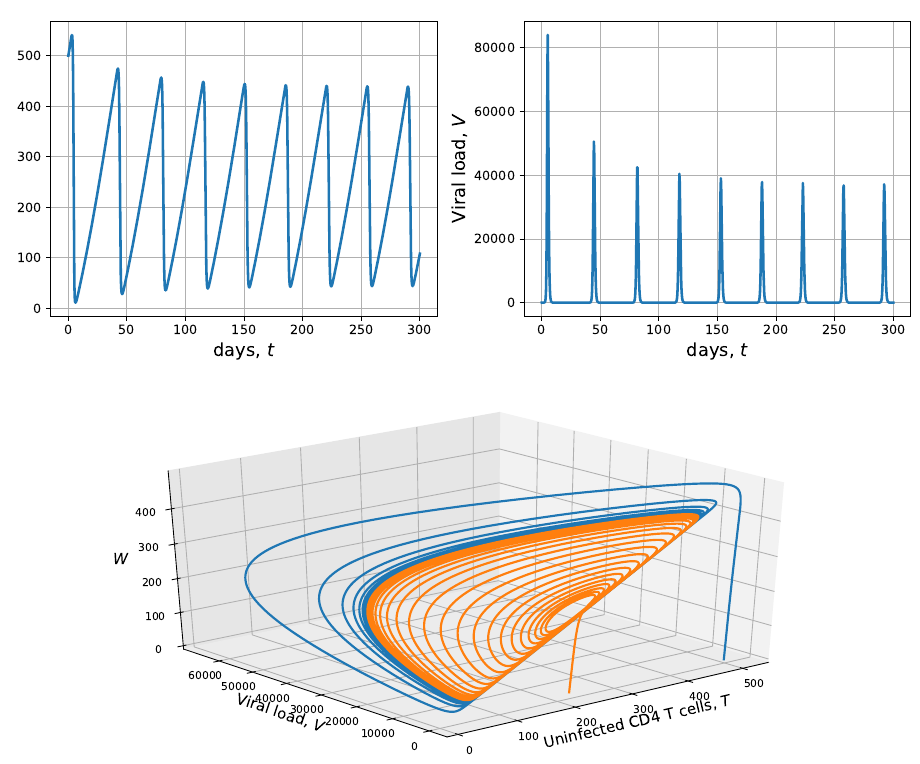
Figure 4. Numeric solutions vs. time ( top panels ) and phase space ( bottom panel ), which correspond to uninfected CD4 T-cells T and viral load ( V ) from Model (10), with a = 2, β = 4 × 10 − 5 and R 0 = 5.0175. In this scenario, the virus-free equilibrium E 1 is unstable. In the phase space, the initial conditions for the blue curve are T ( 0 ) = 500 and V ( 0 ) = 1, and the initial conditions for the orange curve are T ( 0 ) = 230 and V ( 0 ) =